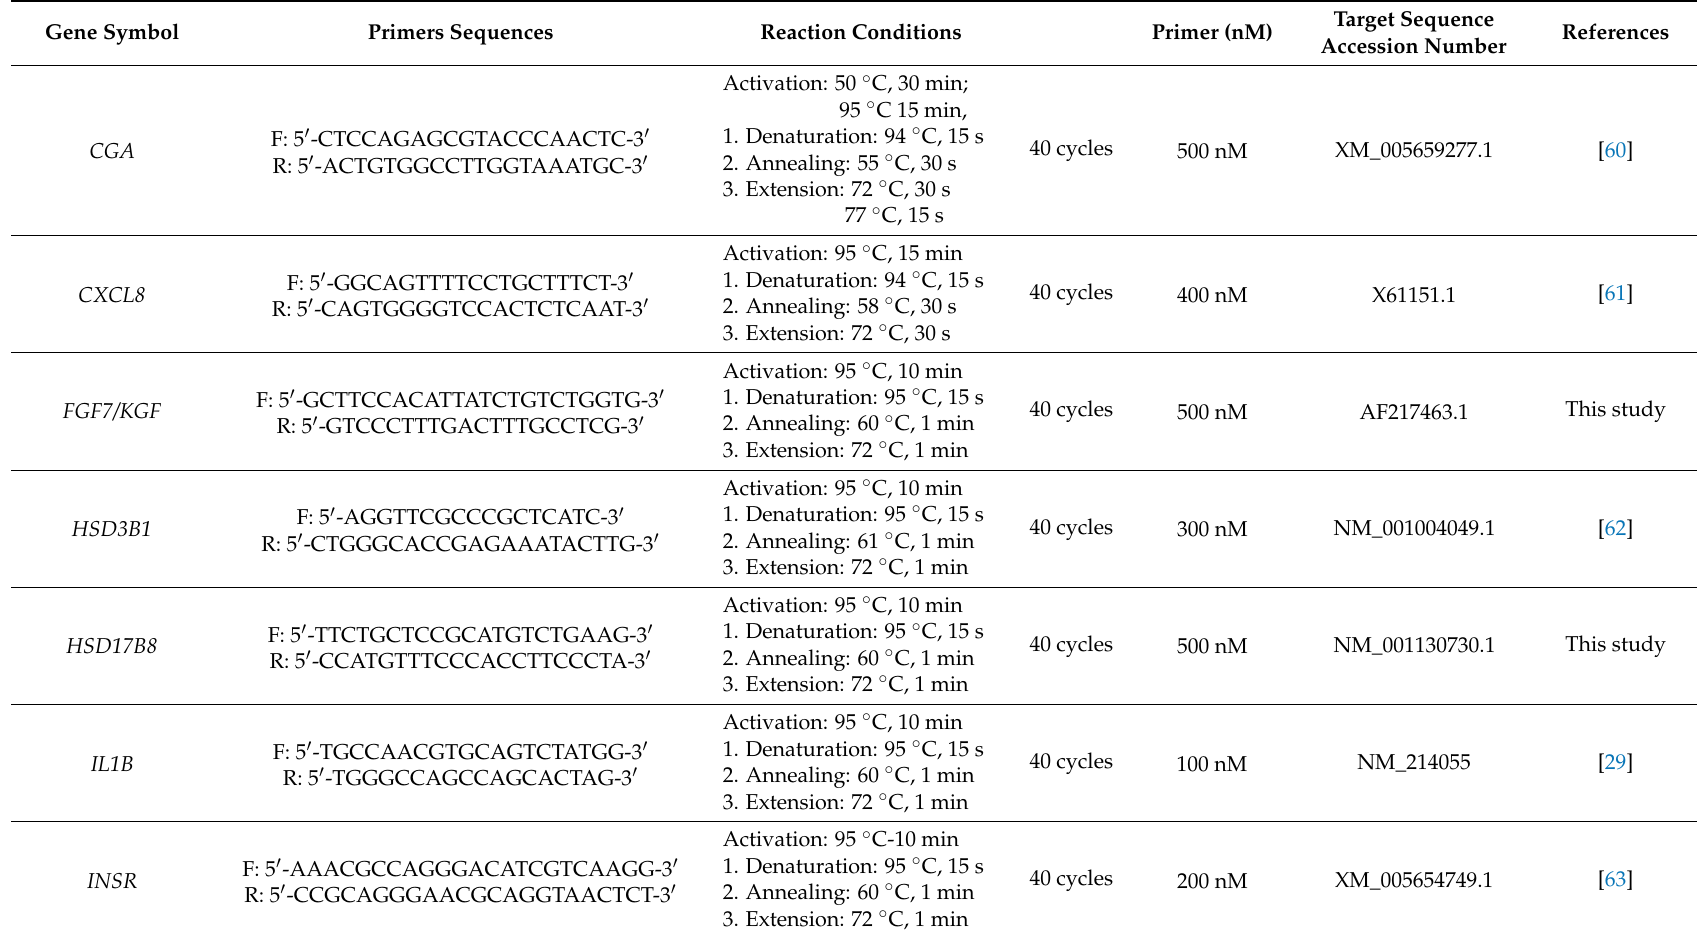
Table 2. Primers used for the validation of microarray